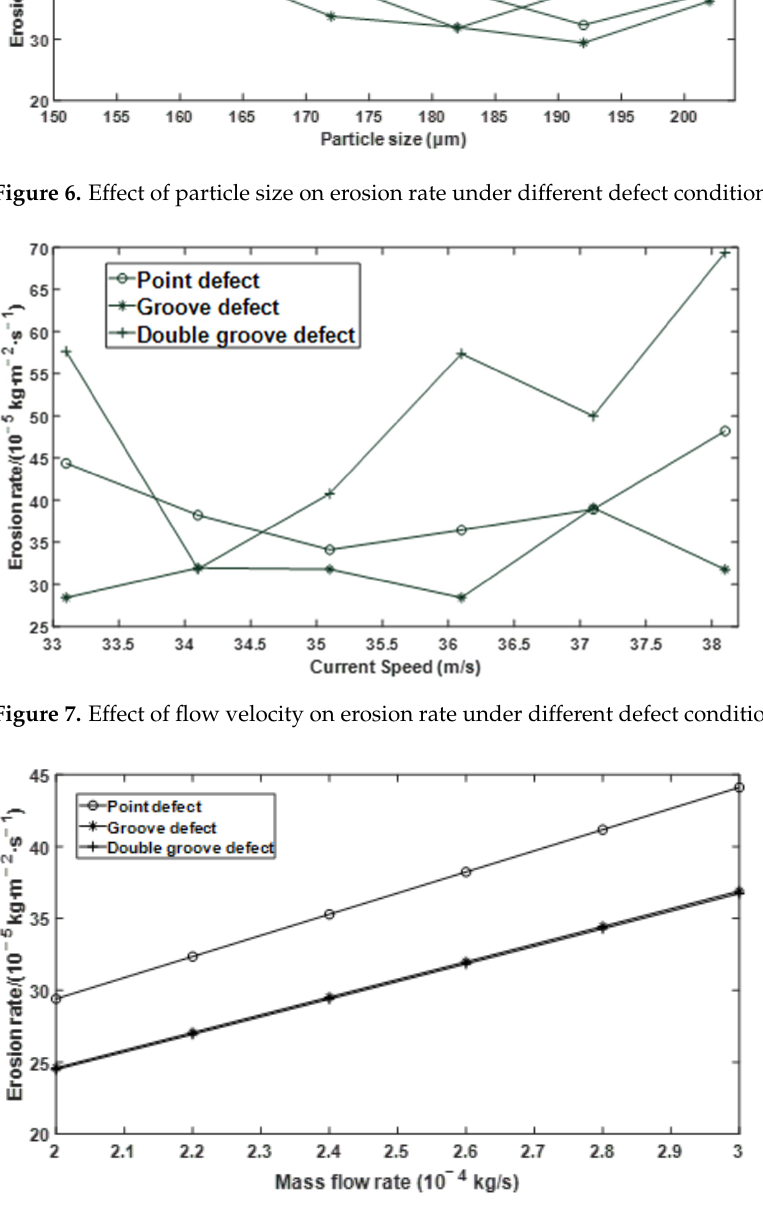
Figure 8. Effect of mass flow rate on erosion rate under different defect conditions.